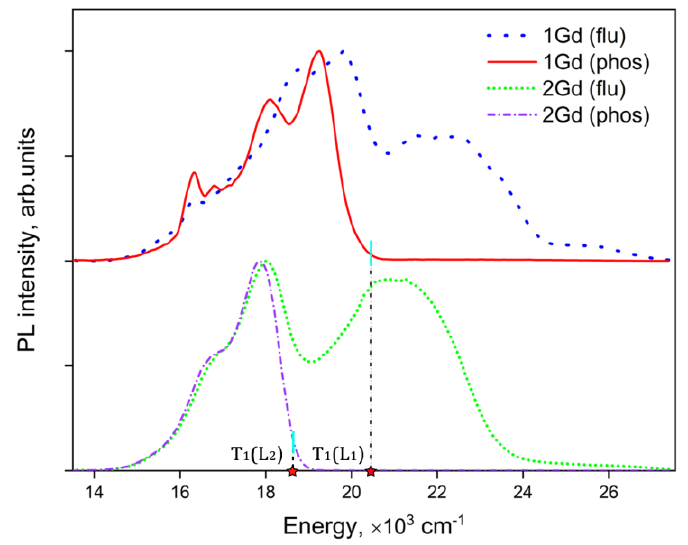
Figure 7. The fluorescence (flu) and phosphorescence (phos) spectra of crystal complexes 1Gd and 2Gd at 77 K.